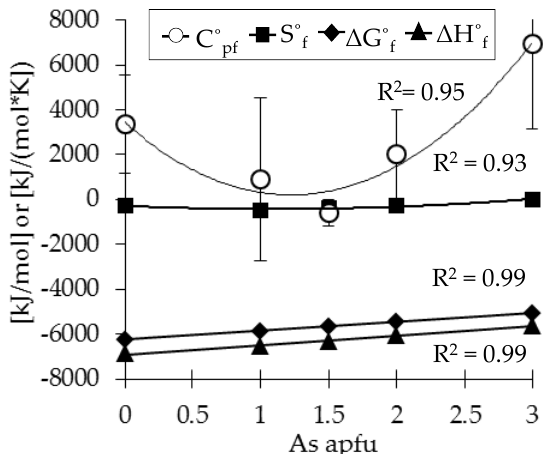
Figure 15. The variability in standard thermodynamic functions of the formation in JBM–HAP solid solution series. The error bars represent two standard deviations of the average calculated from three distinct experimental results at steady state. R 2 represents the coefficient of determination.